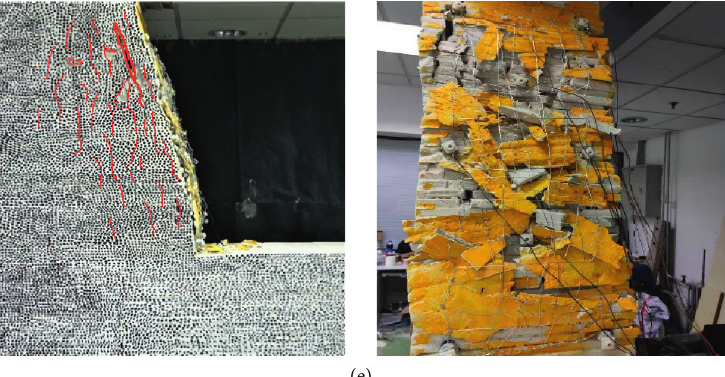
Figure 15: . Photograph of model collapse process: (a) compaction stage: (i) lateral view and (ii) side view; (b) fracture generation stage: (i) lateral view and (ii) side view; (c) fracture propagation stage: (i) lateral view and (ii) side view; (d) local collapse stage: (i) lateral view and (ii) side view; (e) entire collapse stage: (i) lateral view and (ii) side